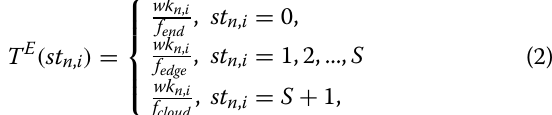
located geographically away from MDs with mighty com- puting power and storage capacity, providing powerful computing resources for MUs. Besides, ESs are deployed in urban areas, providing a certain amount of computing resources for MDs. MDs can communicate with the near- est ES via local area network (LAN). Meanwhile, MDs can also communicate with the remote cloud center through wide area network (WAN)